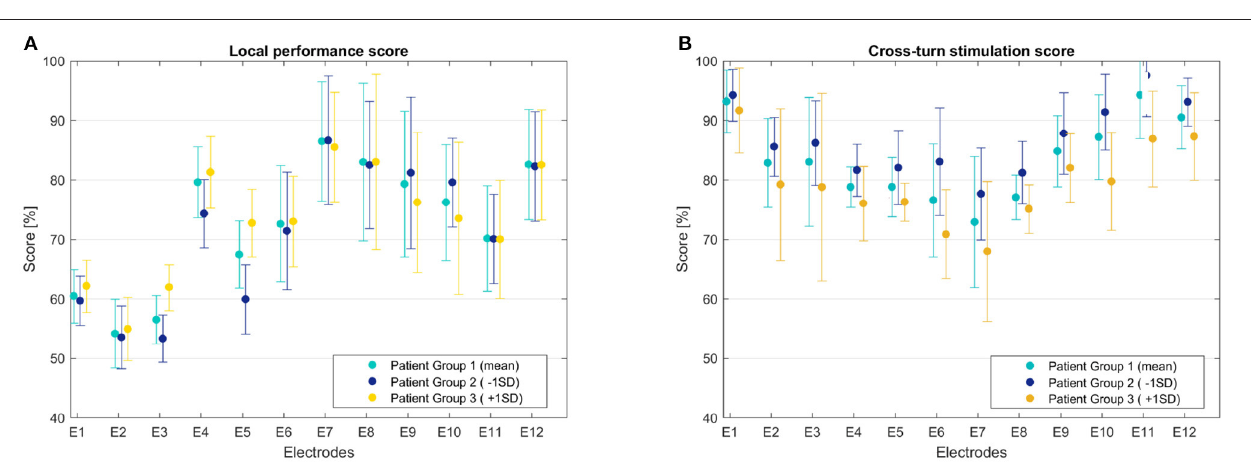
FIGURE 8 | CI outcomes in a population of virtual patients. (A) Local performance score, (B) Cross-turn stimulation